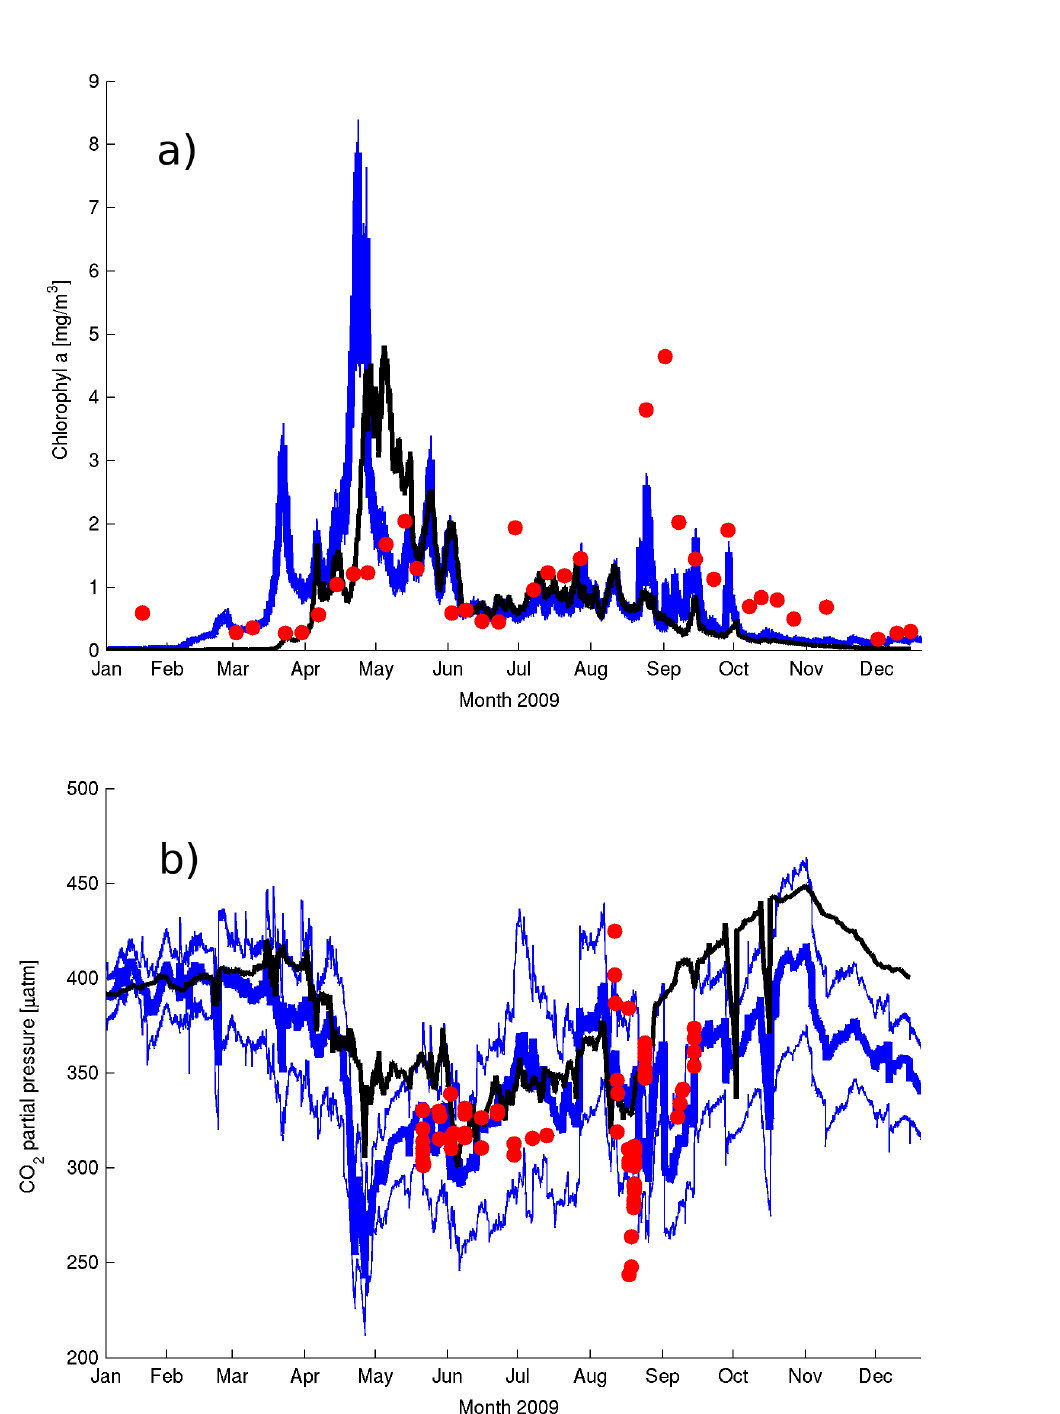
Figure 9. Time evolution of results from Experiment D for ( a ) 10 m chl-a and in situ surface chl-a observations (red dots) and ( b ) mixed layer pCO 2 and in situ observations (black). The solid black line corresponds to the model results from Experiment A. The thicker blue line corresponds to the ensemble mean while the thin blue line corresponds to one standard